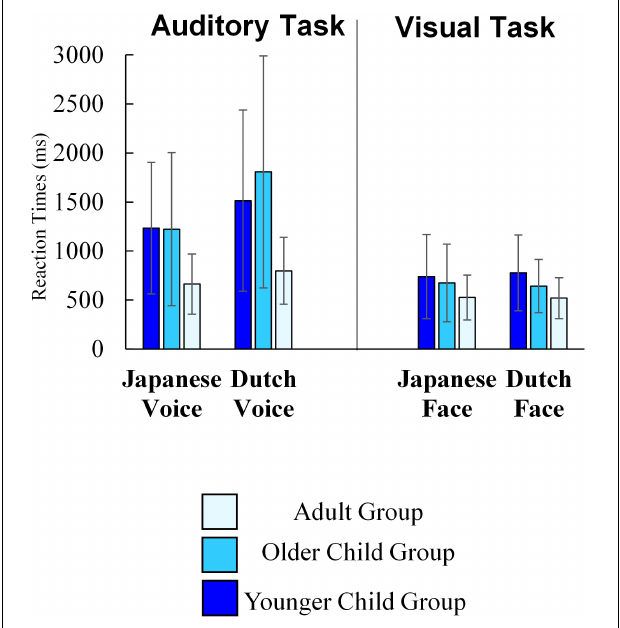
FIGURE 5 | The average of participants’ reaction time in web data (Error bars indicate standard deviations).